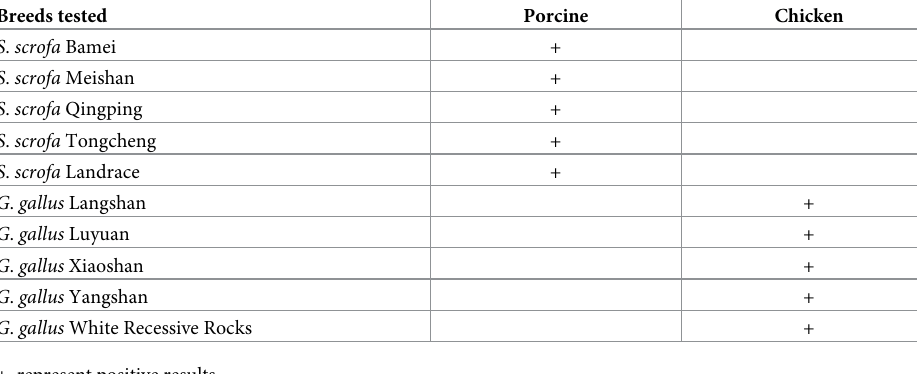
+, represent positive